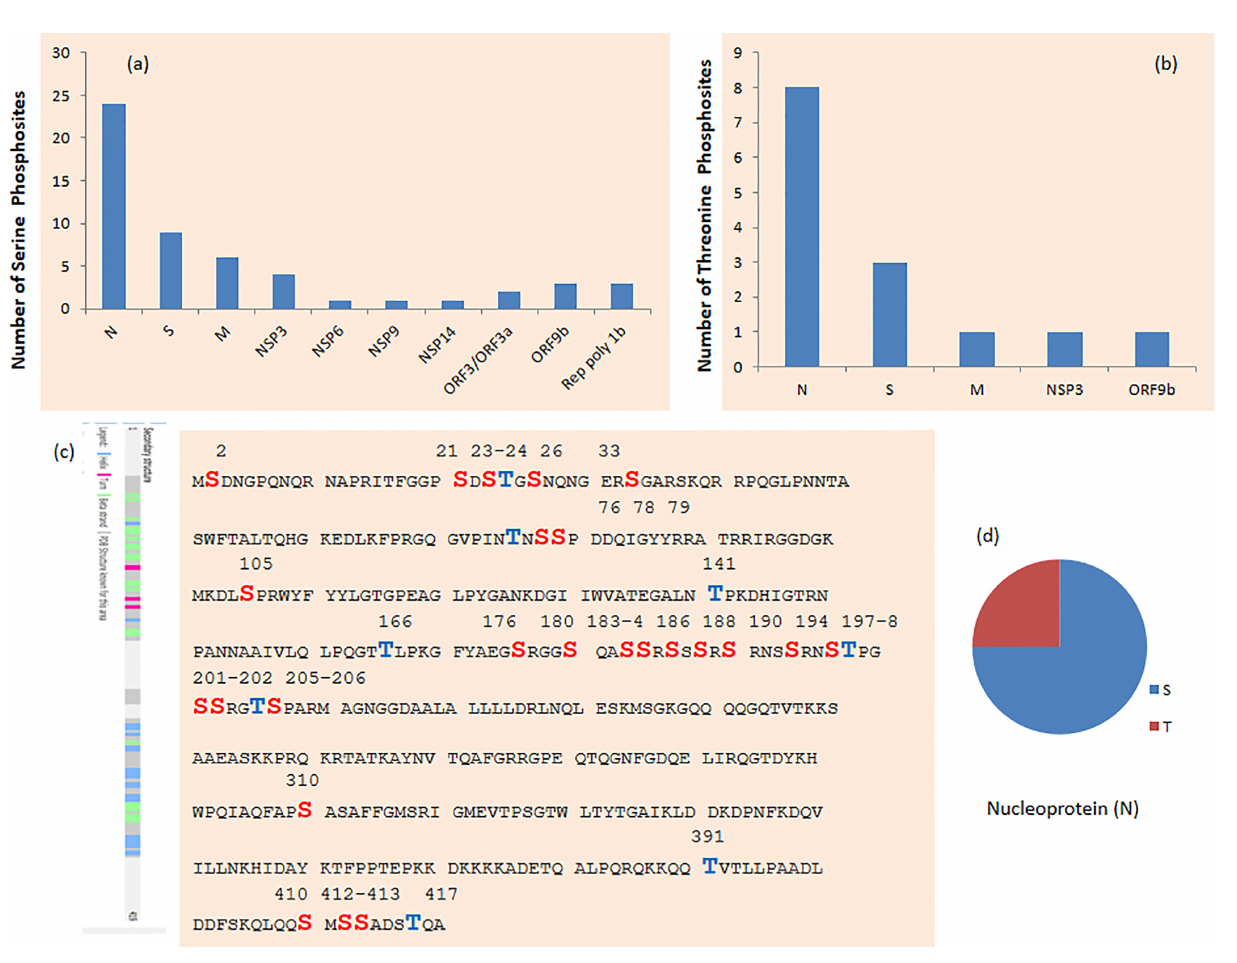
FIGURE 6 | (A) Serine and (B) threonine phosphosites in SARS-CoV-2 protein. (C) Phosphosites in nucleoprotein (N) of SARS-CoV-2. (D) Phosphosites in SARS- CoV-2 protein on serine (S), threonine (T), and tyrosine (Y) on n